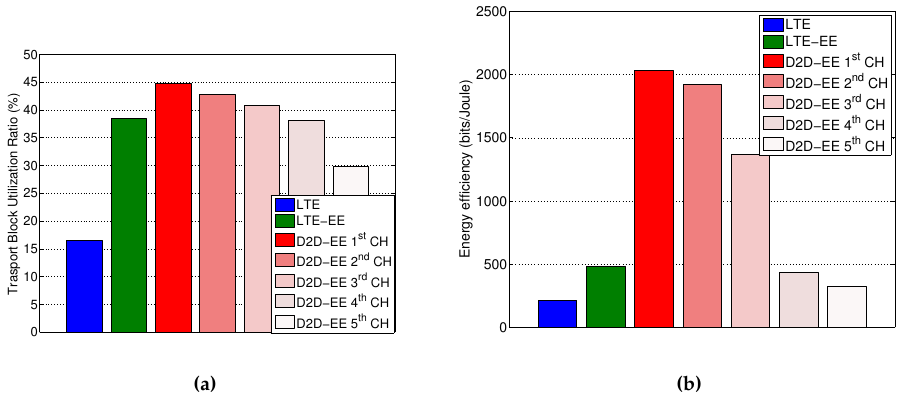
Figure 8. Performance with aggregator role shifting among the devices (50 devices and 10 Bytes data). ( a ) Transport Block utilization; ( b ) Energy